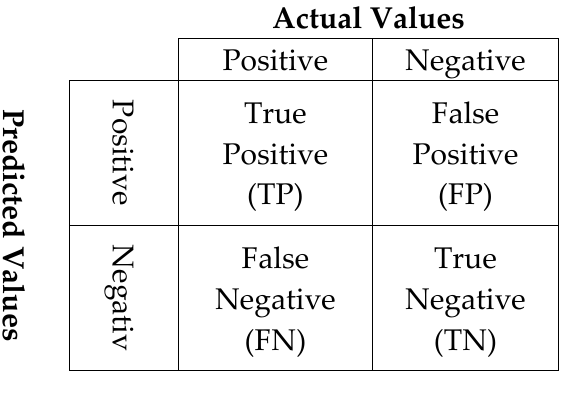
Figure 7. Confusion matrix.